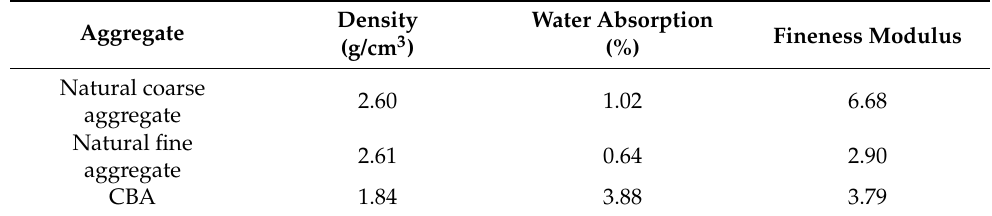
Table 1. Physical properties of aggregates used.